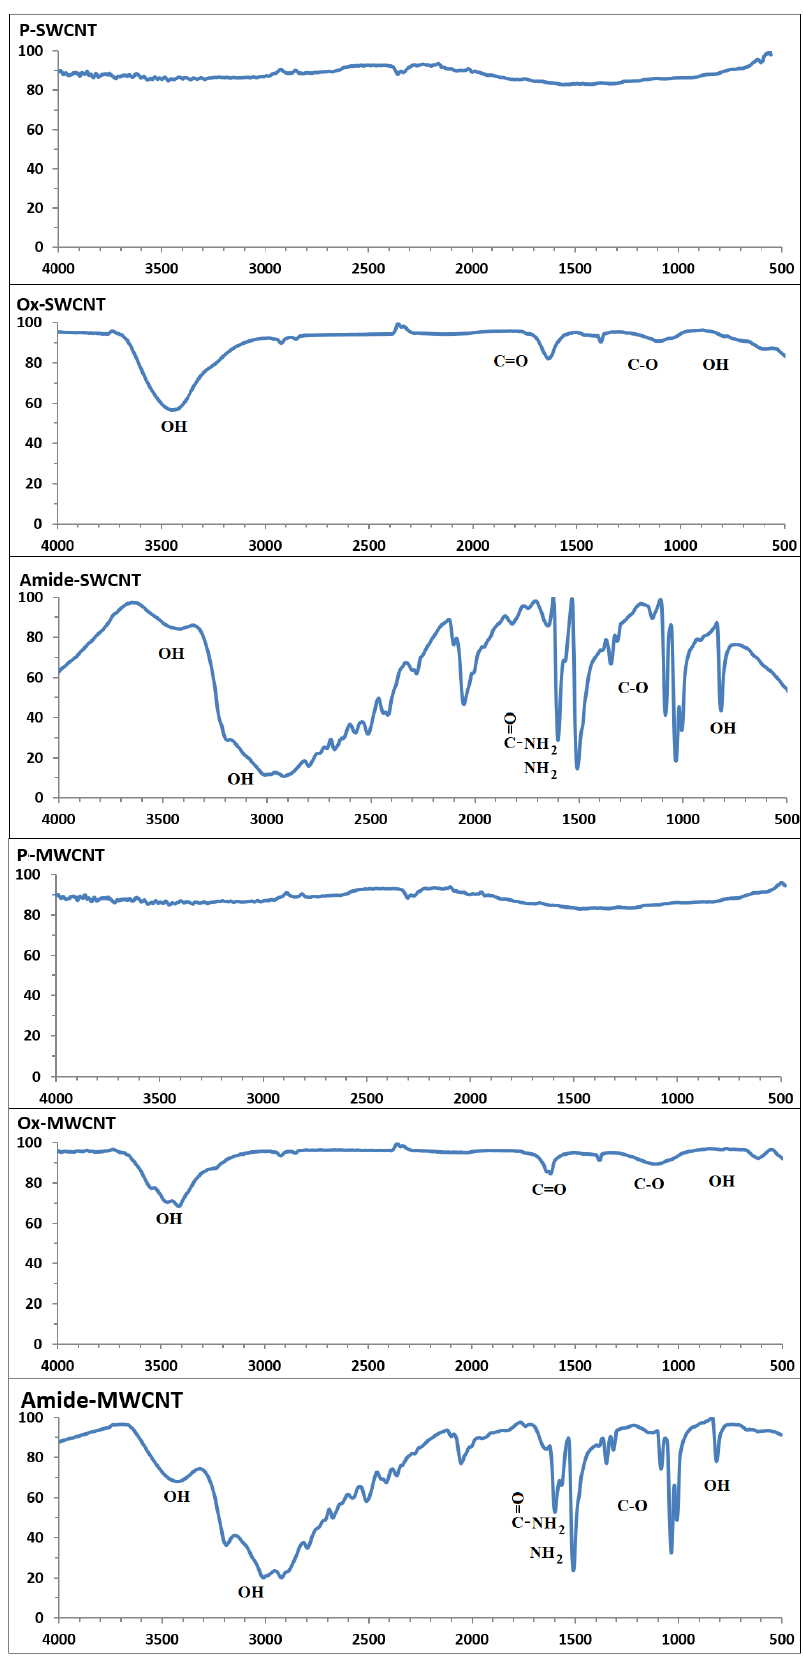
Figure 1. FTIR spectra for the pristine, oxidized and amide CNTs.